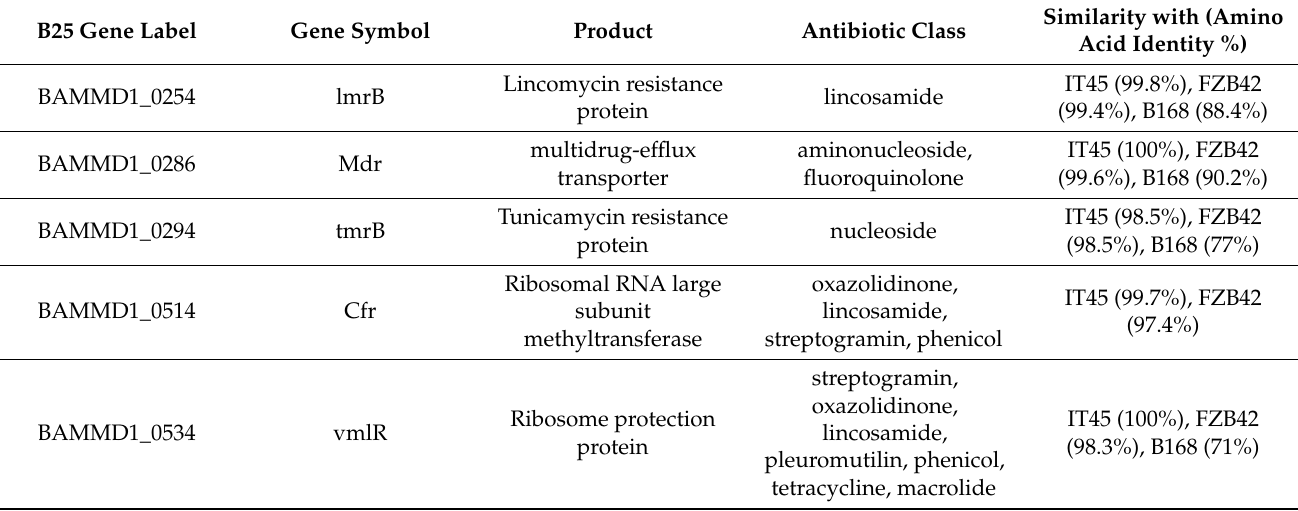
Table 3. Antibiotic resistance genes detected in Bacillus velezensis strain B25